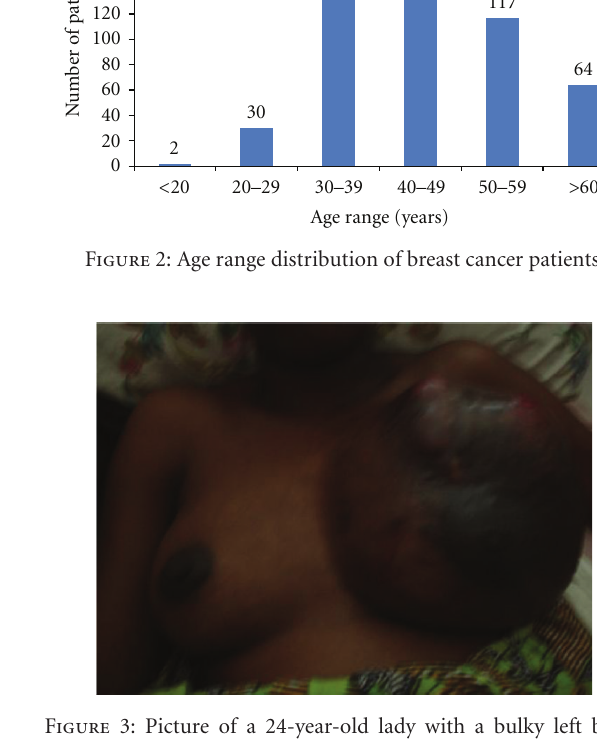
Figure 3: Picture of a 24-year-old lady with a bulky left breast